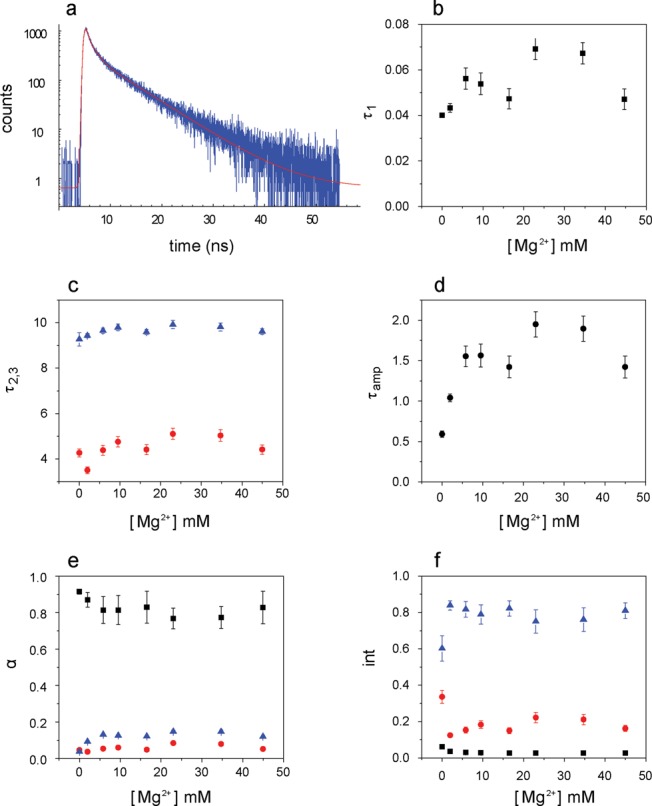
Time-resolved fluorescence decay of Bimane. (a) Decay curve in the trimolecular complex L(dAp)ER(Bim) at 45 mM [Mg2+]. The decay curve was fit with three lifetime components; (b–d) [Mg2+] dependence of the single fluorescence lifetime components and of the amplitude averaged fluorescence lifetime (black squares, \documentclass[12pt]{minimal}
\usepackage{amsmath}
\usepackage{wasysym}
\usepackage{amsfonts}
\usepackage{amssymb}
\usepackage{amsbsy}
\usepackage{upgreek}
\usepackage{mathrsfs}
\setlength{\oddsidemargin}{-69pt}
\begin{document}
}{}$\tau _{1}$\end{document}, red circles, \documentclass[12pt]{minimal}
\usepackage{amsmath}
\usepackage{wasysym}
\usepackage{amsfonts}
\usepackage{amssymb}
\usepackage{amsbsy}
\usepackage{upgreek}
\usepackage{mathrsfs}
\setlength{\oddsidemargin}{-69pt}
\begin{document}
}{}$\tau _{2}$\end{document}, blue triangles, \documentclass[12pt]{minimal}
\usepackage{amsmath}
\usepackage{wasysym}
\usepackage{amsfonts}
\usepackage{amssymb}
\usepackage{amsbsy}
\usepackage{upgreek}
\usepackage{mathrsfs}
\setlength{\oddsidemargin}{-69pt}
\begin{document}
}{}$\tau _{3}$\end{document} and black circles, \documentclass[12pt]{minimal}
\usepackage{amsmath}
\usepackage{wasysym}
\usepackage{amsfonts}
\usepackage{amssymb}
\usepackage{amsbsy}
\usepackage{upgreek}
\usepackage{mathrsfs}
\setlength{\oddsidemargin}{-69pt}
\begin{document}
}{}$\tau _{{\rm amp}}$\end{document}); (e) fractional amplitudes α; and (f) fractional intensities (\documentclass[12pt]{minimal}
\usepackage{amsmath}
\usepackage{wasysym}
\usepackage{amsfonts}
\usepackage{amssymb}
\usepackage{amsbsy}
\usepackage{upgreek}
\usepackage{mathrsfs}
\setlength{\oddsidemargin}{-69pt}
\begin{document}
}{}$\alpha _i \cdot \tau _i$\end{document}) of the three decay components; Conditions: 4.2 μM L(dAp), 4.1 μM E, 4.0 μM R(Bim), pH 7.5; 15°C; λexc = 405 nm, λem = 480 nm.